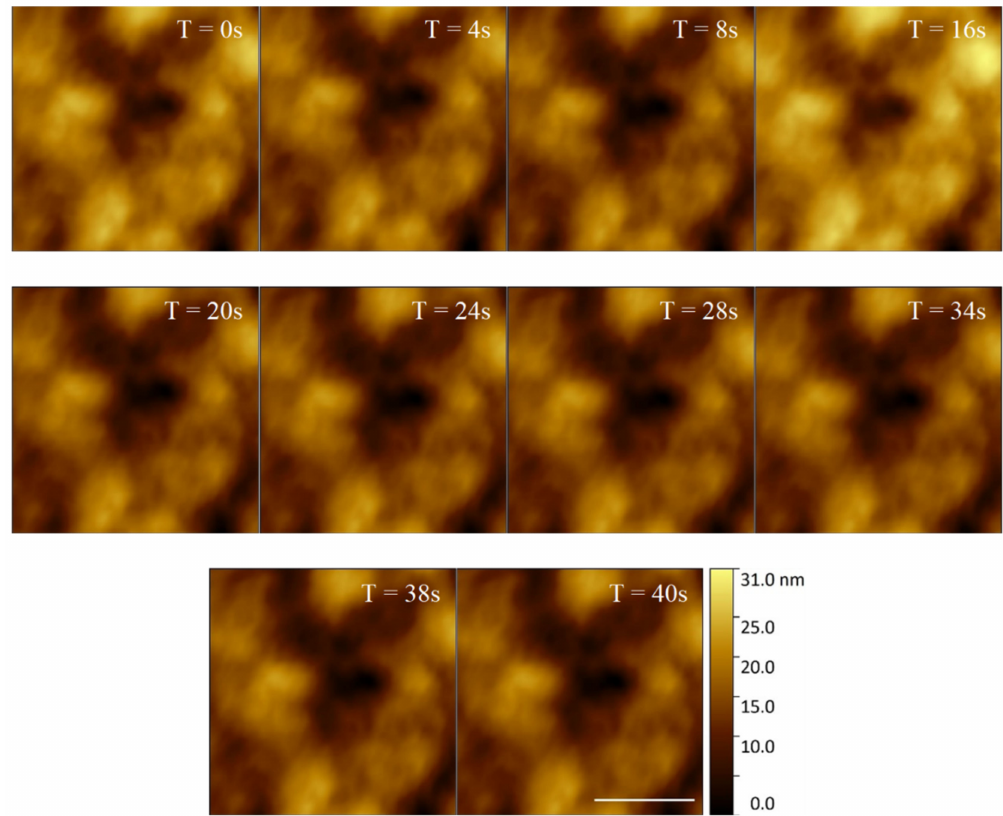
Figure 5. 40 s time series of an E. huxleyi cell membrane visualised by HS-AFM in liquid (Scale bar 500 nm, Individual frames captured at 2 fps).